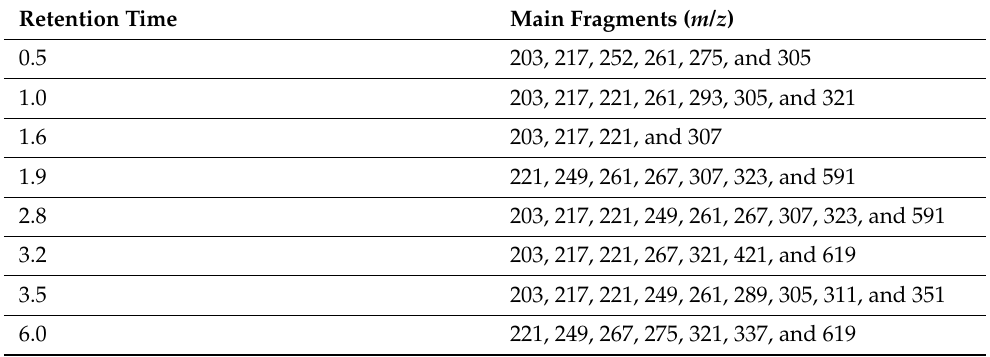
Table 2. Retention time and fragmentation patterns of ARTS reaction products in methanol: